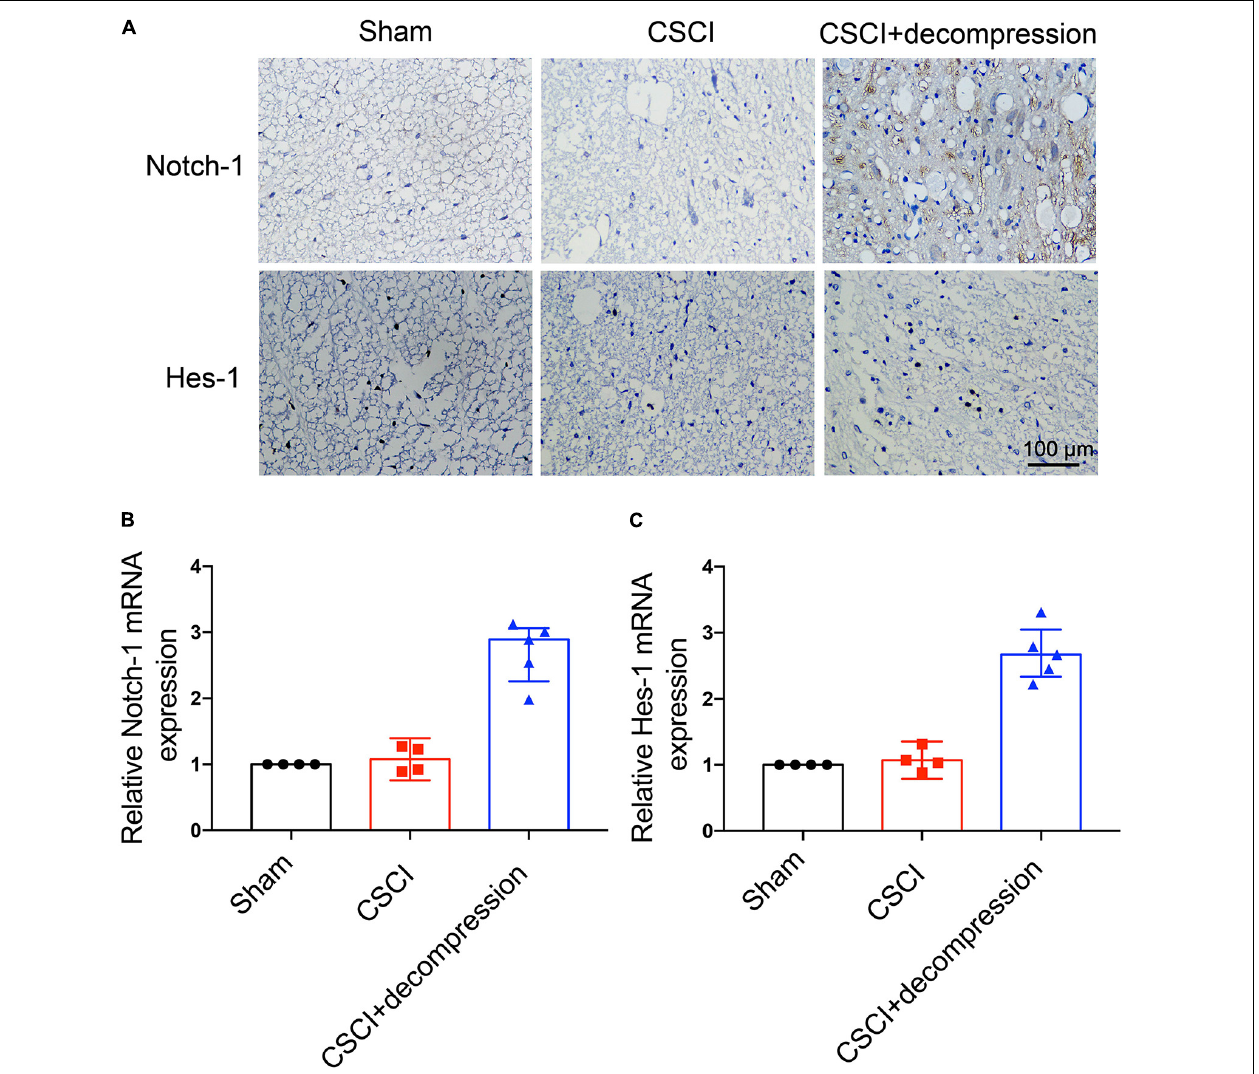
FIGURE 5 | Decompression-induced up-regulated Notch-1 expression. (A) Notch-1 and Hes-1 expression was assessed by IHC (400 × magnification; scale bar, 100 µ m). (B) Relative Notch-1 expression and (C) relative Hes-1 expression, as assessed by RT-qPCR. IHC: n = 6 each group; RT-qPCR: The Sham group: n = 4; CSCI group: n = 4; CSCI with decompression group: n = 5; Medians ± interquartile ranges, the sample size was too low to perform statistics for these data.